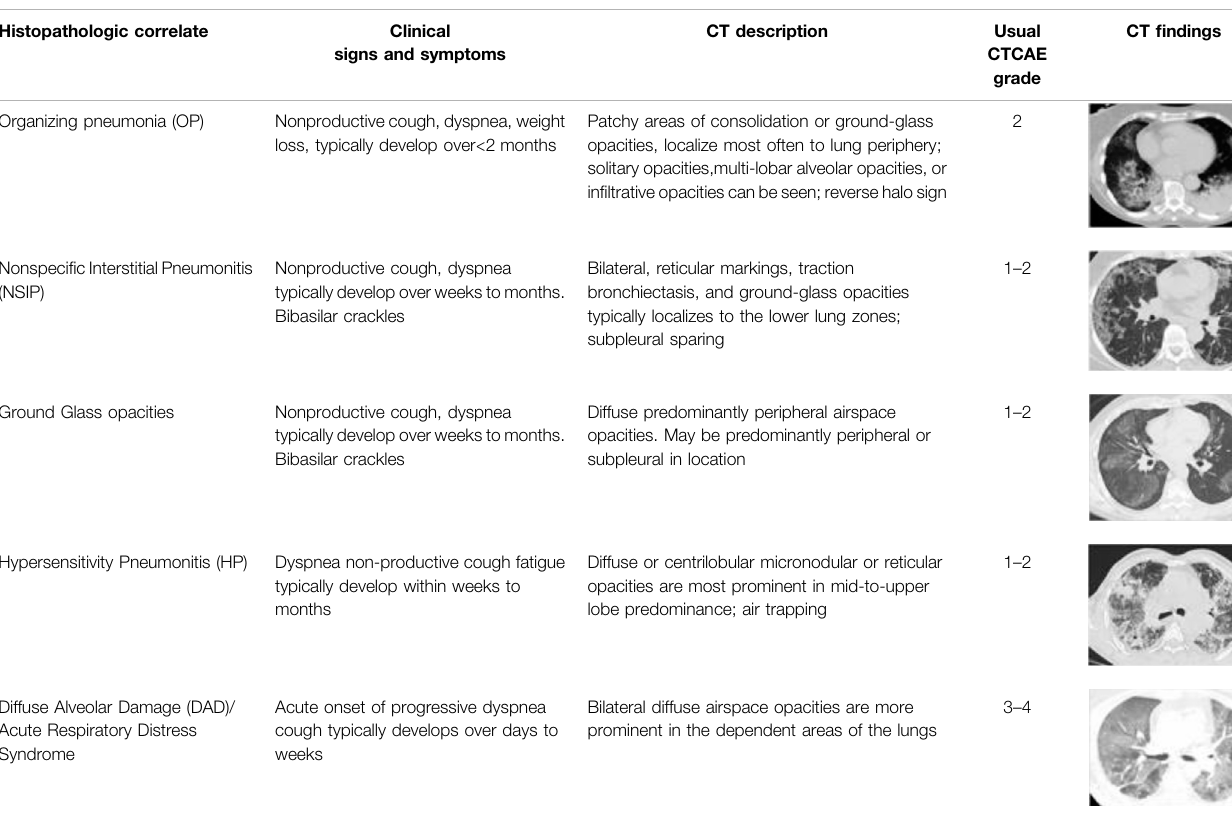
TABLE 3 | Pneumonitis patterns associated with ICI-related lung injury. Histopathologic